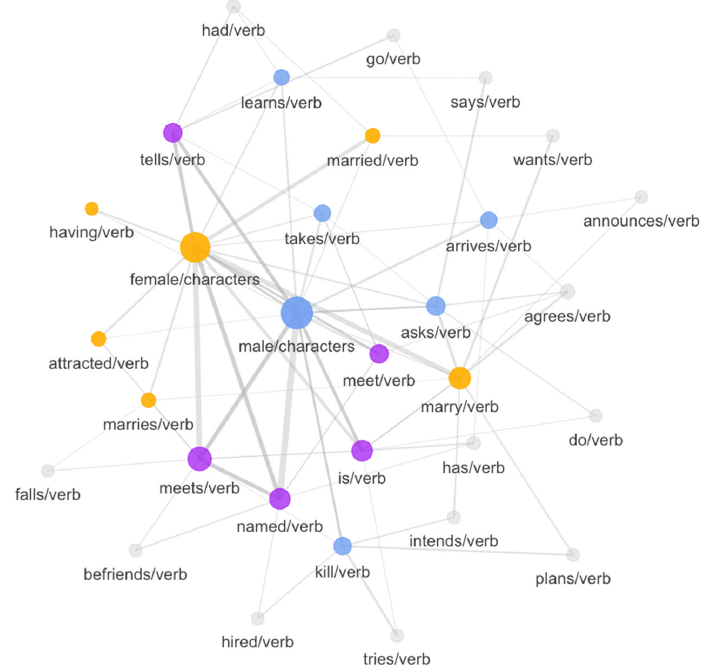
Figure 9. Most significant primary verb associations with males and females. Verbs found to strongly co-occur with female characters included ‘marry’ and ‘married’; for male characters, they included ‘kill’ and ‘arrives’. Verbs such as ‘named’ and ‘meets’ co-occurred strongly with both female and male characters. Table 4. Linear regression analysis of edge weight regressed on decade for stereotypical verbs. ** p < 0.01, * p < 0.05.